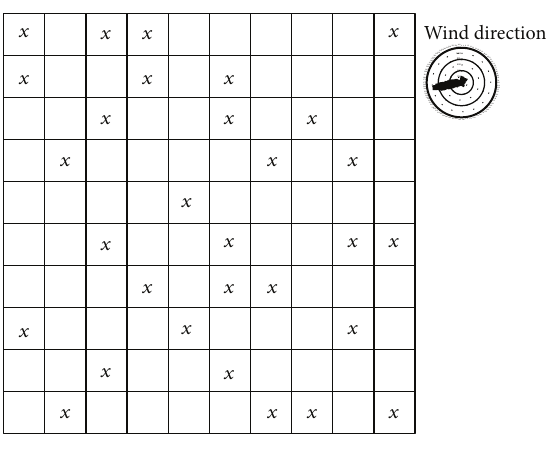
Figure 12: Optimal placement after 10,000 Monte Carlo simulation runs (case 1).